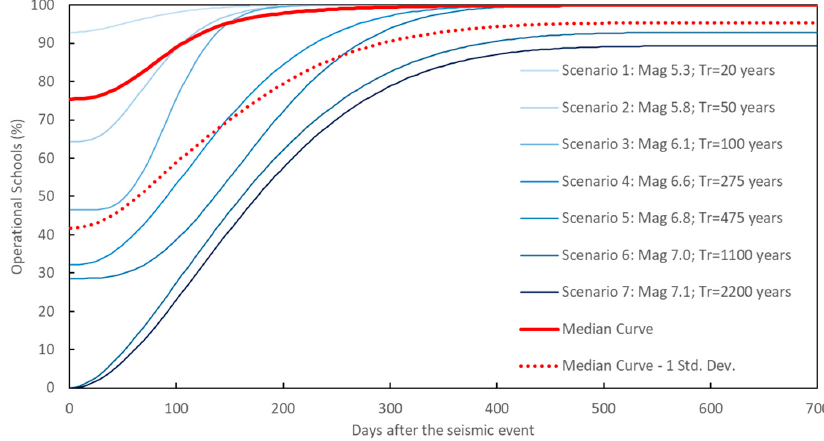
Figure 15. Resilience curves of the school buildings portfolio (28 schools) for seven seismic sce- narios.